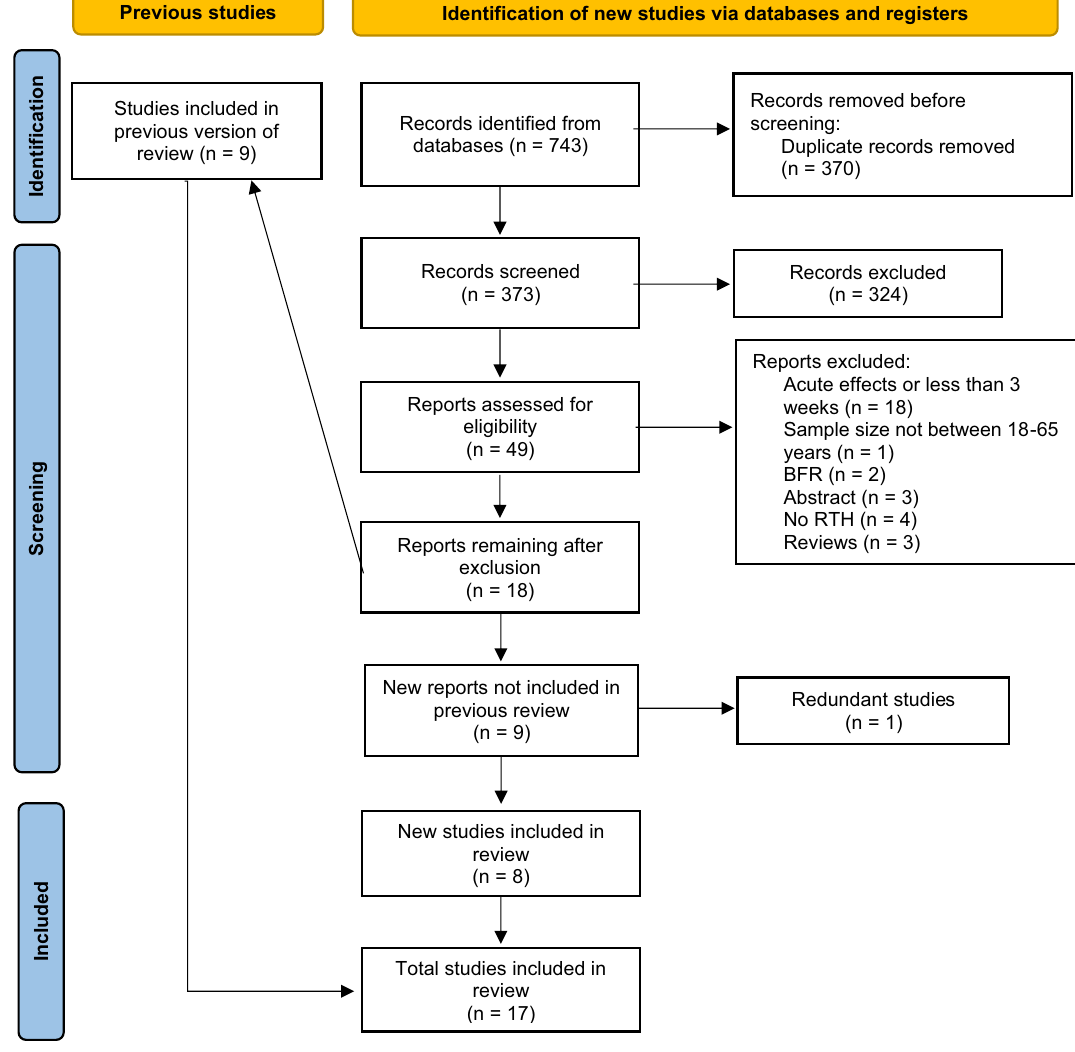
Figure 1. Flow diagram of the search and selection of